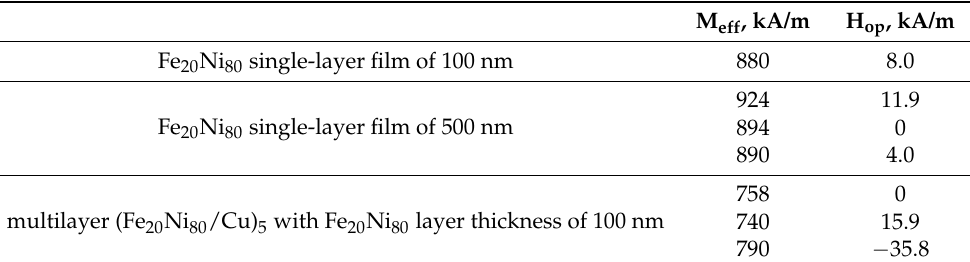
Table 1. The parameters of the single-layered films Fe 20 Ni 80 (100 nm and 500 nm) and multilayered film (Fe 20 Ni 80 /Cu) 5 with the Fe 20 Ni 80 layer thickness of 100 nm, determined from the angular dependences of the